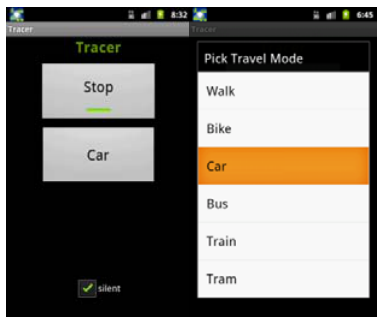
Figure 1. Graphical User Interface of the Tracer App: